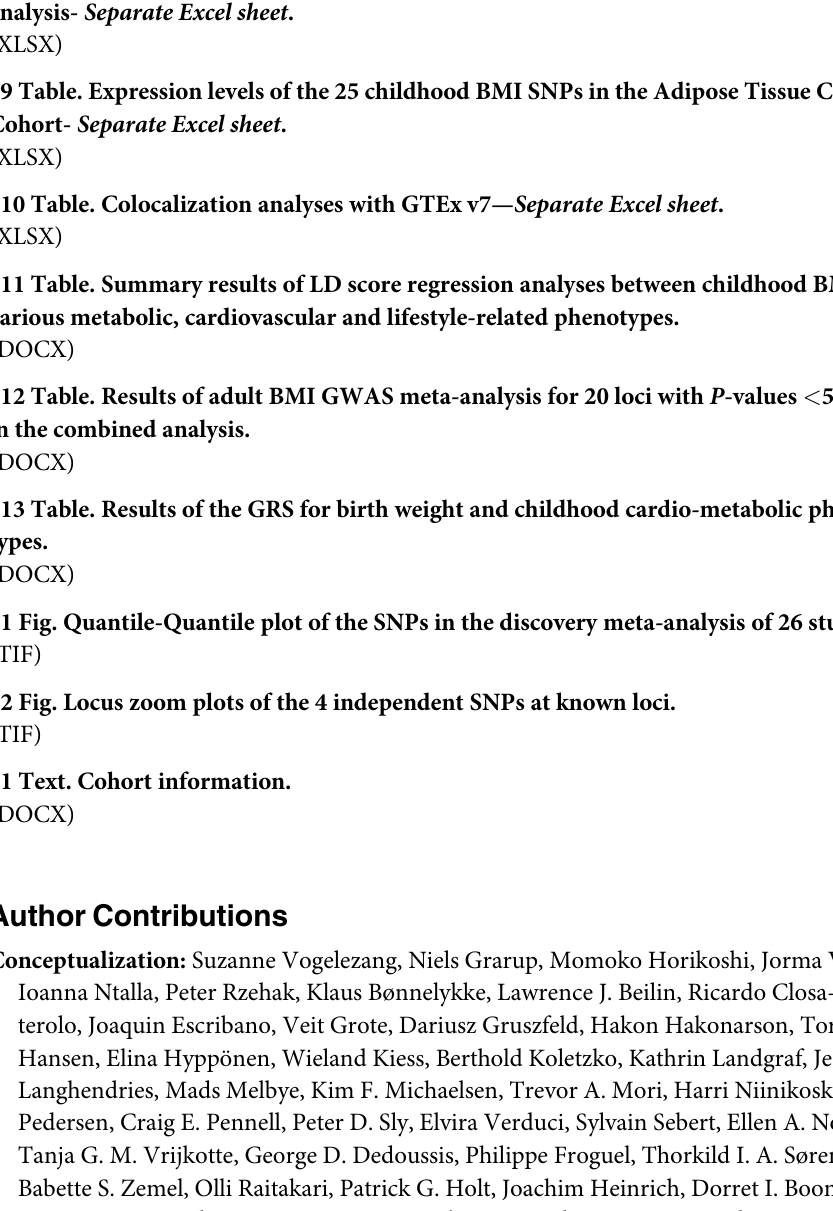
S7 Table. Results of the combined analyses for the 25 SNPs excluding case-control studies and excluding studies with a sample size smaller than n = 500. S8 Table. Look up of the 25 nearest genes and candidate genes indicated by colocalization analysis- Separate Excel sheet . S9 Table. Expression levels of the 25 childhood BMI SNPs in the Adipose Tissue Childhood Cohort- Separate Excel sheet . S10 Table. Colocalization analyses with GTEx v7— Separate Excel sheet . S11 Table. Summary results of LD score regression analyses between childhood BMI and various metabolic, cardiovascular and lifestyle-related phenotypes. S12 Table. Results of adult BMI GWAS meta-analysis for 20 loci with P- values < 5 x 10 − 8 in the combined analysis. S13 Table. Results of the GRS for birth weight and childhood cardio-metabolic pheno- types. S1 Fig. Quantile-Quantile plot of the SNPs in the discovery meta-analysis of 26 studies. (TIF) S2 Fig. Locus zoom plots of the 4 independent SNPs at known